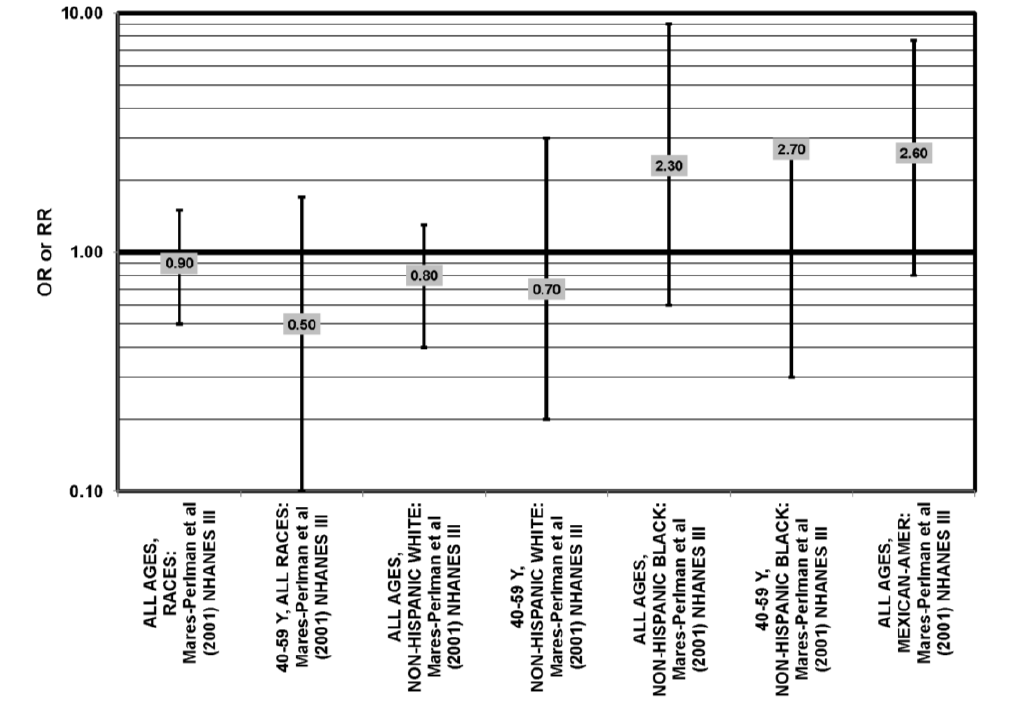
Figure 26. Odds or risk ratio for pigmentary abnormalities; high vs. low serum levels of lutein and zeaxanthin: retrospective and cross-sectional studies.